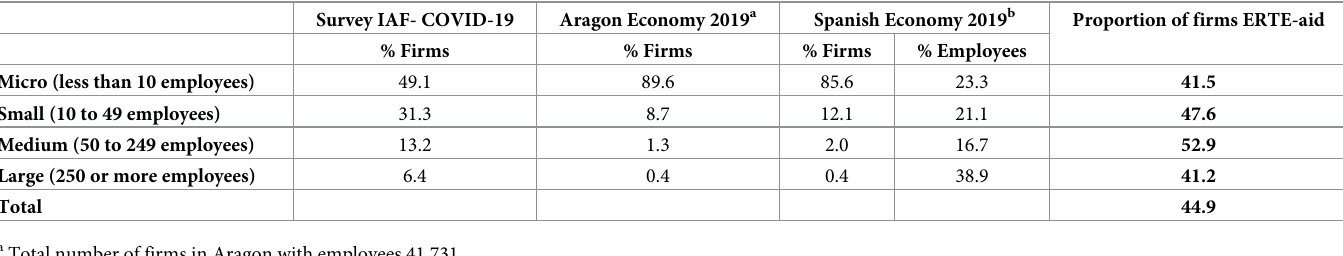
Table 2. Distribution of the sample of responding firms by firm